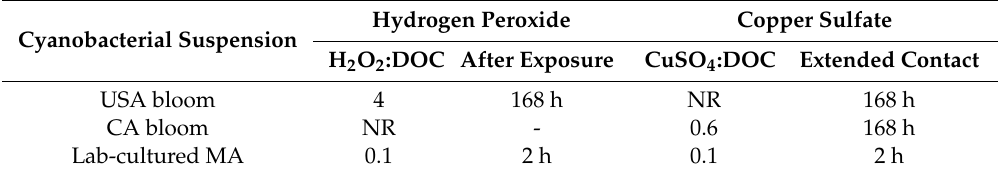
Table 2. Dose ratio or time required for the release of MCs in the two bloom samples and lab-cultured MA. NR: no release of MCs observed at dose applied.